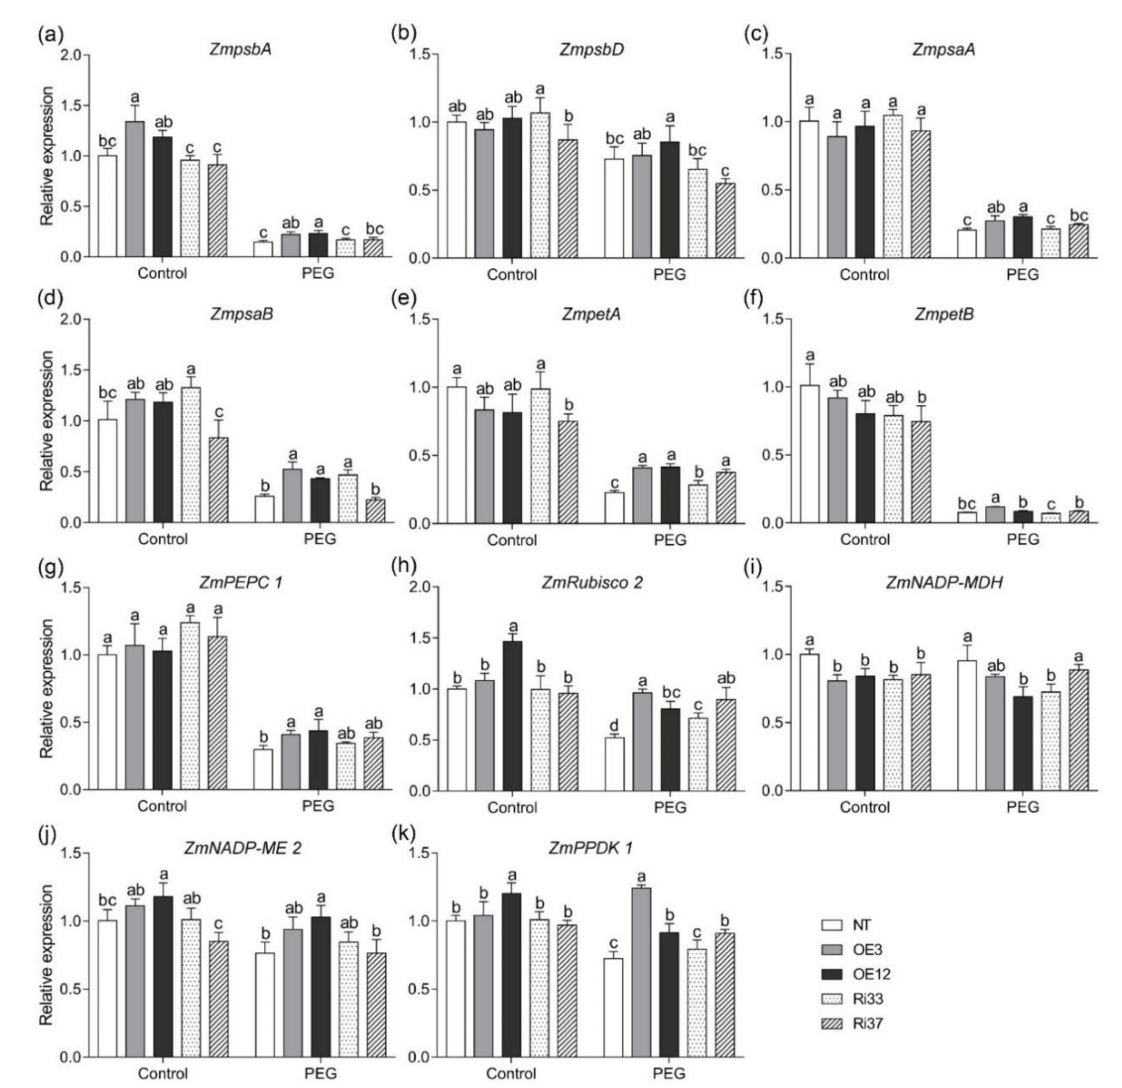
Figure 6. Effects of CgbHLH001 overexpression on photosynthesis-related genes of maize seedlings under drought stress. ( a ) ZmpsbA (encoding the PSII D1 protein); ( b ) ZmpsbD (encoding the PSII D2 protein); ( c ) ZmpsaA (encoding the PSI P700 apoprotein A1); ( d ) ZmpsaB (encoding the PSI P700 apoprotein A2); ( e ) ZmpetA (encoding the apocytochrome f precursor); ( f ) ZmpetB (encoding the cytochrome b6); ( g ) ZmPEPC (phosphoenol-pyruvate carboxylase); ( h ) ZmRubisco (ribulose- 1, 5-bisphosphate carboxylase/oxygenase); ( i ) ZmNADP-MDH (NADP-malic dehydrogenase); ( j ) ZmNADP-ME (NADP-malic enzyme); ( k ) ZmPPDK (pyruvate orthophosphate dikinase).